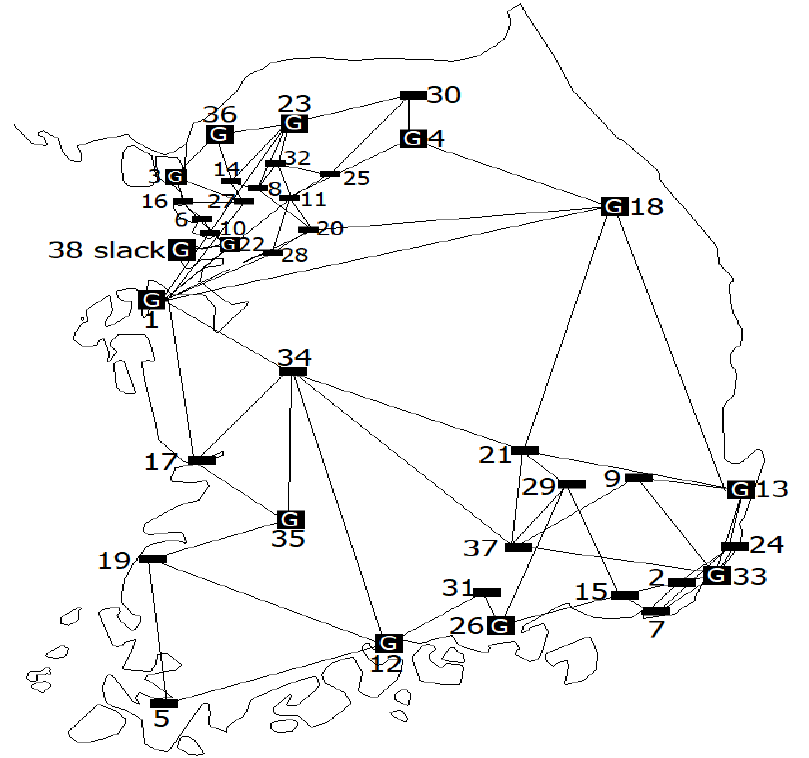
Figure 4. Geographic representation of the reduced 38-bus Korean power system.